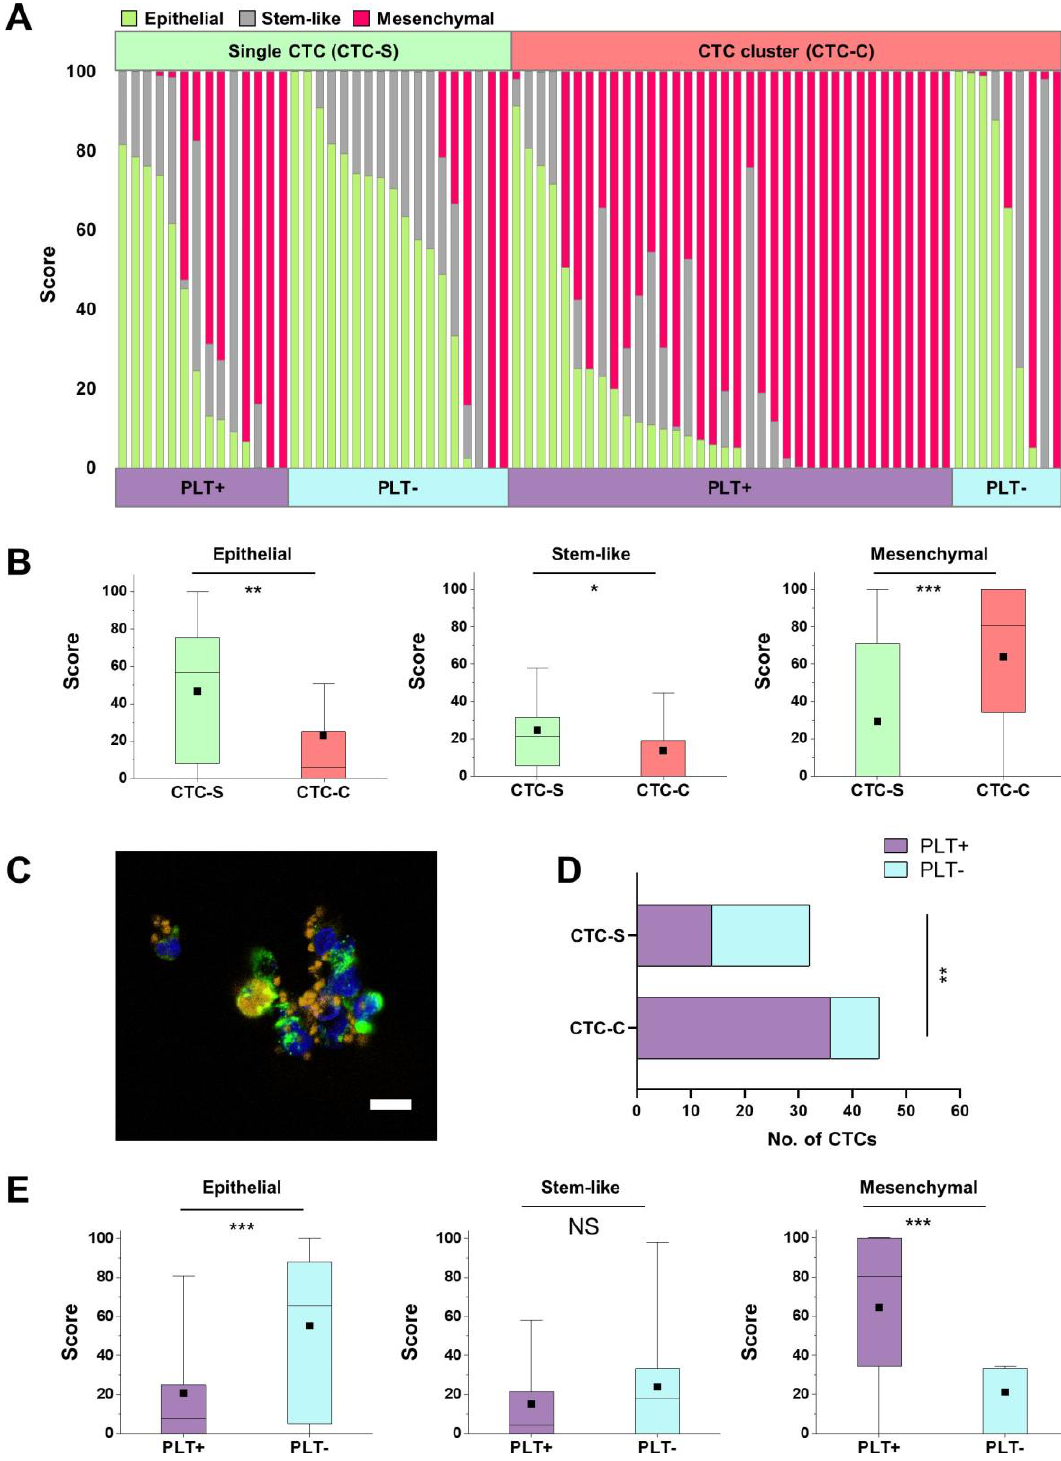
Figure 3. Circulating tumor cell (CTC) characterization according to the subtypes. ( A ) CTCs classified into three categories (epithelial, stem-like, and mesenchymal CTCs) according to their subtypes: (1) CTC-S (single CTC) or CTC-C (CTC cluster) and (2) PLT+ group (platelet marker-positive group) or PLT − group (platelet marker-negative group). ( B ) The score of the three categories between CTC-S and CTC-C. Box plots show 25th and 75th percentiles, with lines indicating the median value and black square dots indicating the mean value. All the differences for the three categories between the two groups are statistically significant (* p < 0.05, ** p < 0.01, *** p < 0.001). ( C ) Fluorescence images of CTC-S (left) and CTC-C (right) with P-selectin-stained platelets at 60× (scale bar: 10 µm). ( D ) Fisher’s exact test based on the analysis of contingency tables between CTC-S and CTC-C according to the platelet marker expression ( p = 0.0015). ( E ) The score for the three categories between the PLT+ group and the PLT− group. Box plots show 25th and 75th percentiles , with lines indicating the median